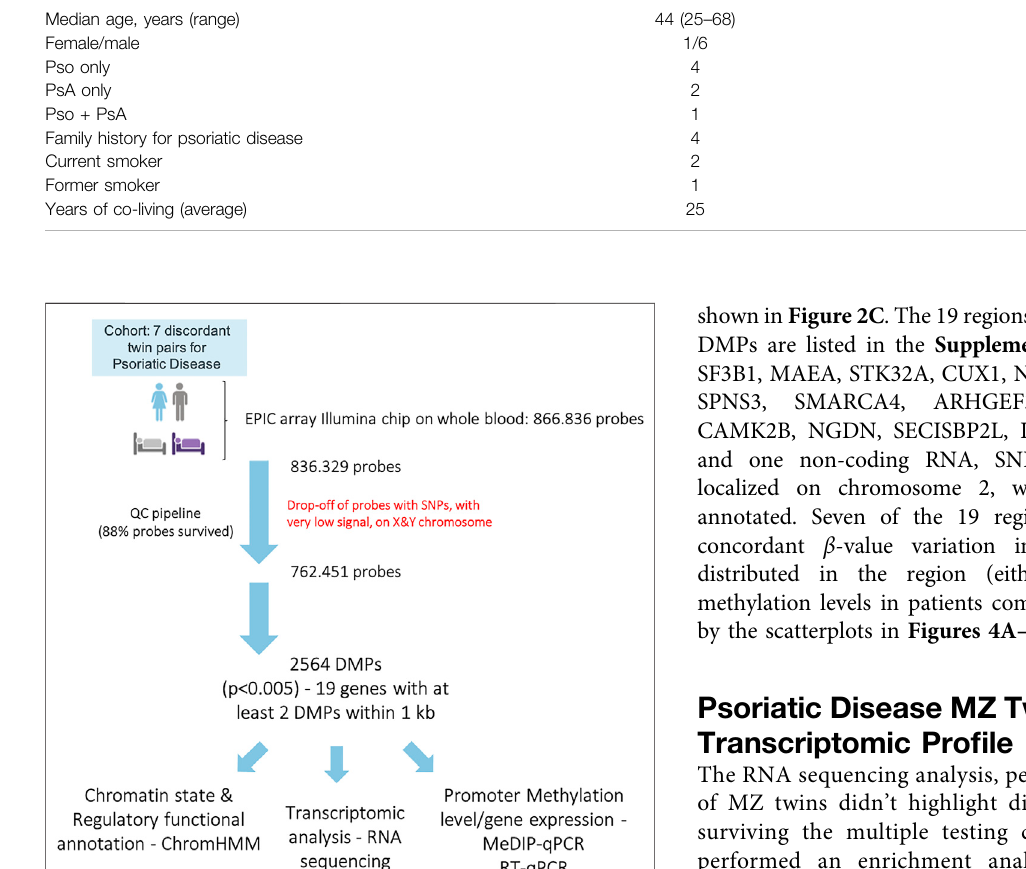
Frontiers in Cell and Developmental Biology |